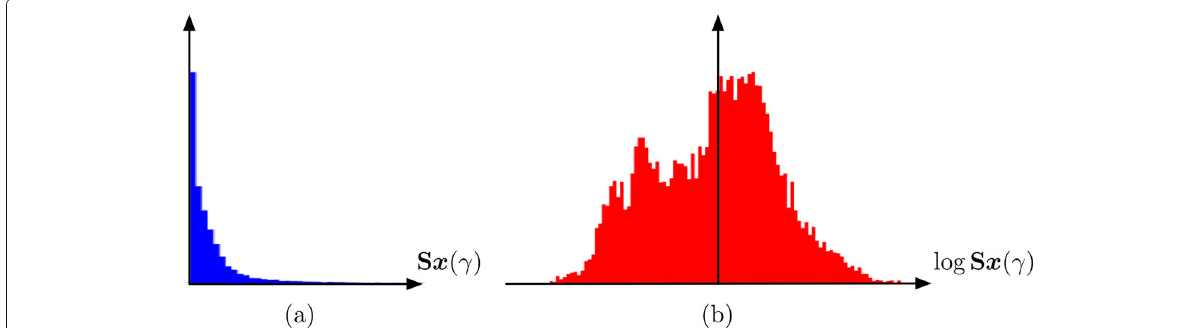
Fig. 2 Histogram of values taken by the first-order scattering coefficient S x (γ) , corresponding to a central acoustic frequency of 302Hz, a before and b after logarithmic